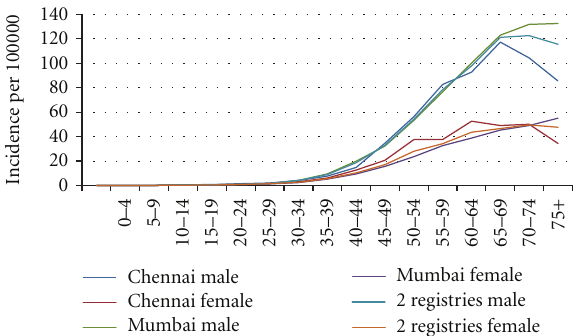
Figure 1: Age specific incidence rates lip, oral cavity cancer (includes: pharynx) 1983–2002. source: Ferlay et al. [26], IARC: